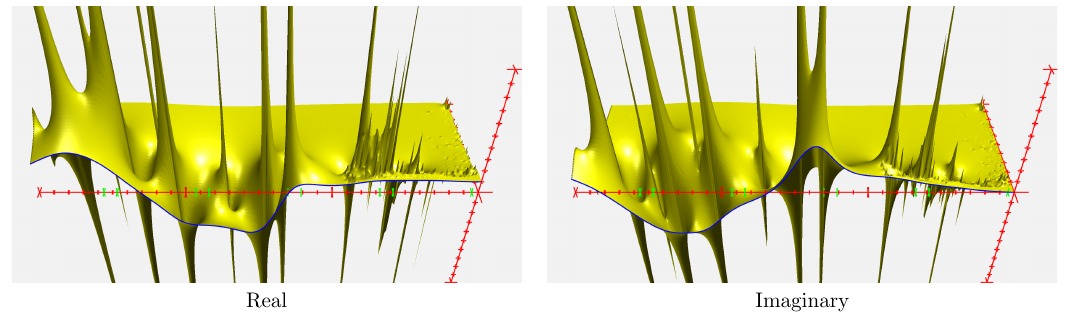
Fig. 5. The real and imaginary components of the response function plotted as a function of complex angular velocity at St. Malo. The origin (0, 0) is on the right with the positive real axis (in red) running from right to left and the negative imaginary axis running into the figure. Function values on the real axis are plotted in blue. The axes have red crosses every 1 rad/day. On the real axis green crosses indicate the limits of the tidal bands near 0 (long period), 1 (diurnal), 2 (semi-diurnal), 3 and 4 cycles per